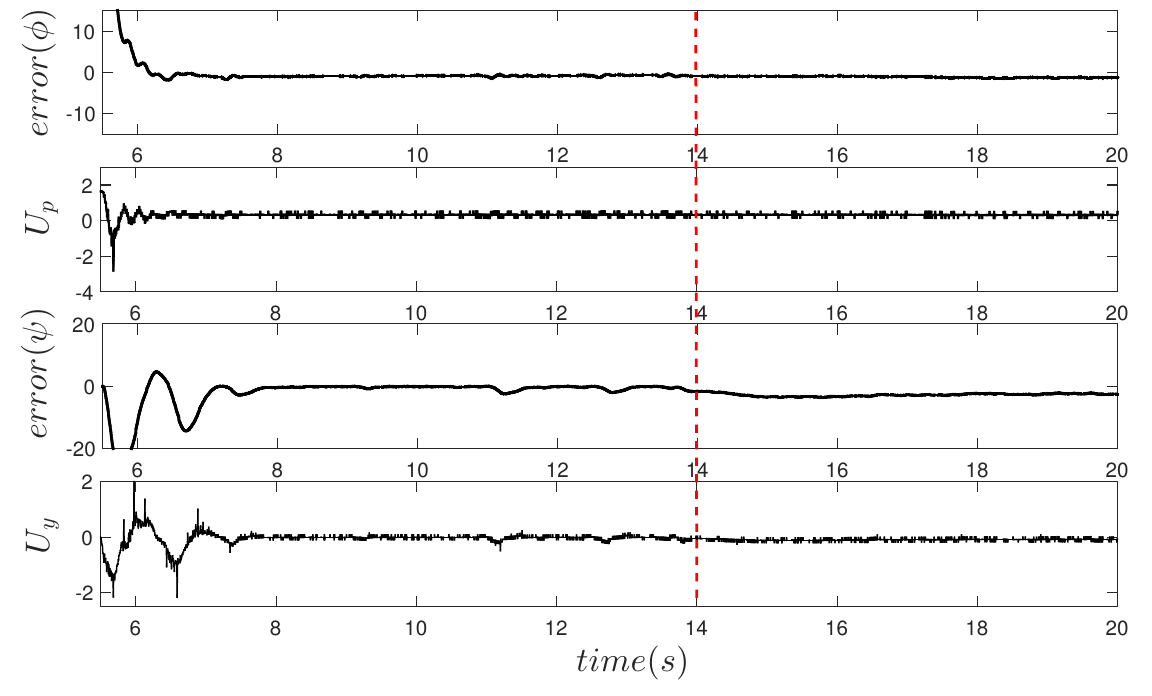
Figure 13. Response to the presence of failure in actuator f a 2 of 25%.